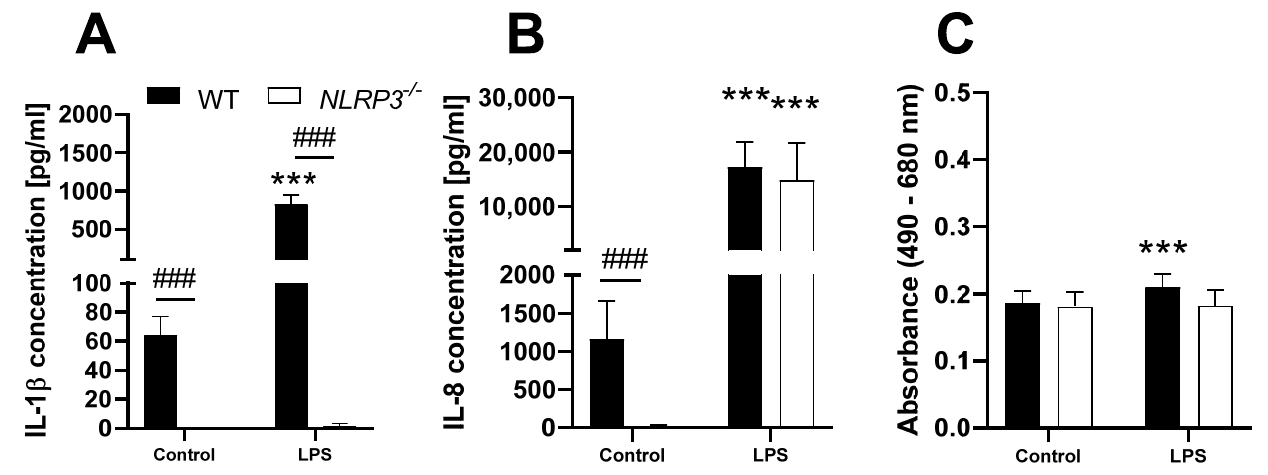
Figure 3. Release of IL-1 β ( A ) and IL-8 ( B ), as well as LDH activity ( C ) in the supernatant of PMA-